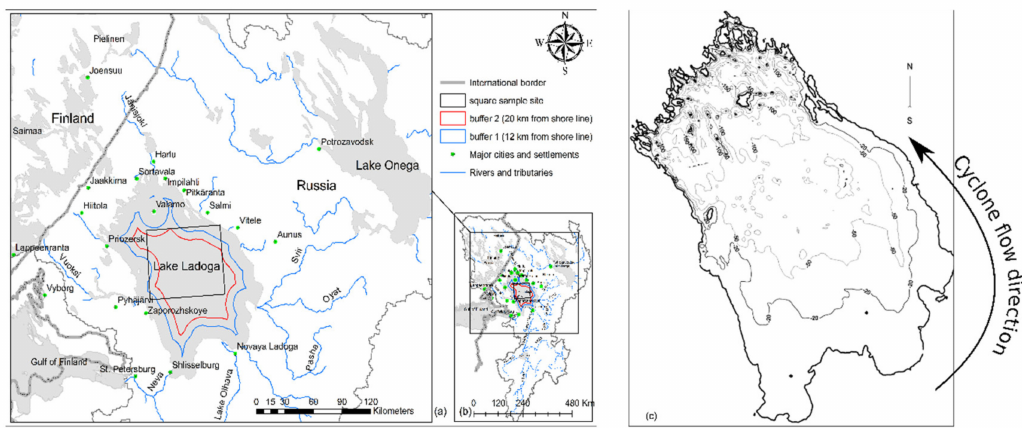
(upper right), and Gulf of Finland (lower left corner), bu ff er 1, bu ff er 2, square are sample sites. In ( b ), Lake Ladoga drainage basin. In ( c ), is the bathymetric map of Lake Ladoga (image adapted and modified from Subetto et al. 1998